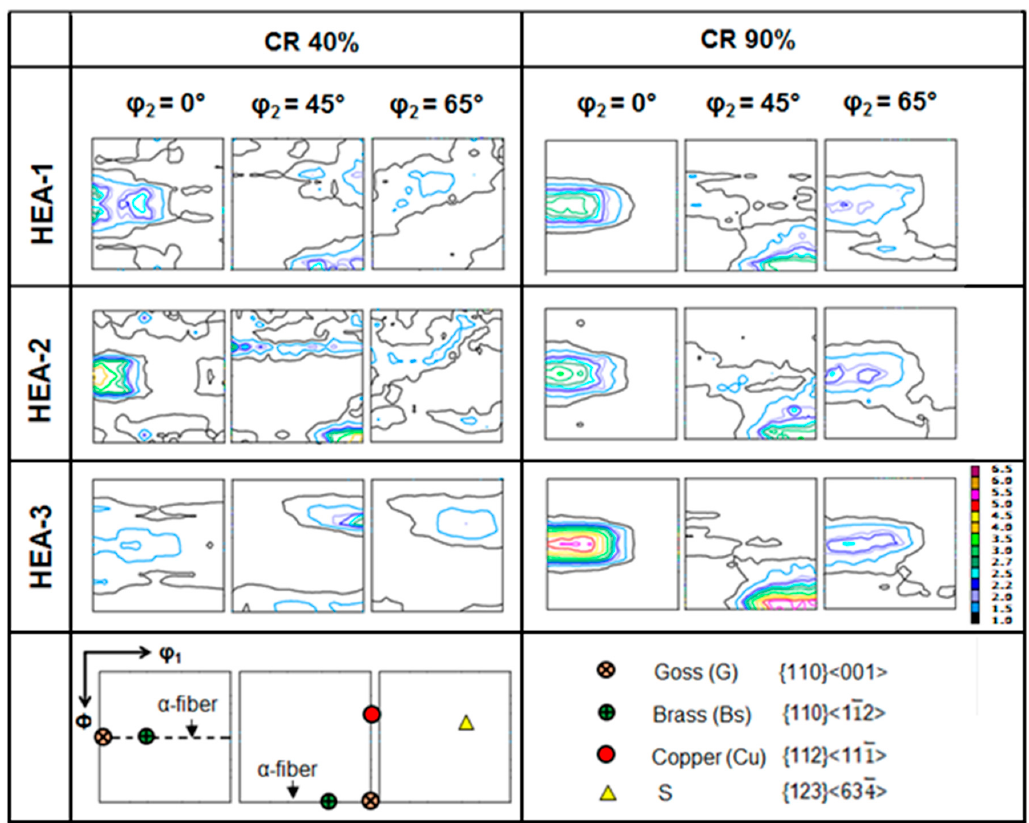
Figure 5. Texture of cold-rolled (CR) HEAs 1–3 represented by ϕ 2 = 0°, 45°, and 65° orientation distribution function (ODF) sections (intensities are given in multiples of a random distribution). Lower ODF sections give the position of the typical rolling components of face-centered cubic (FCC) metals and alloys.